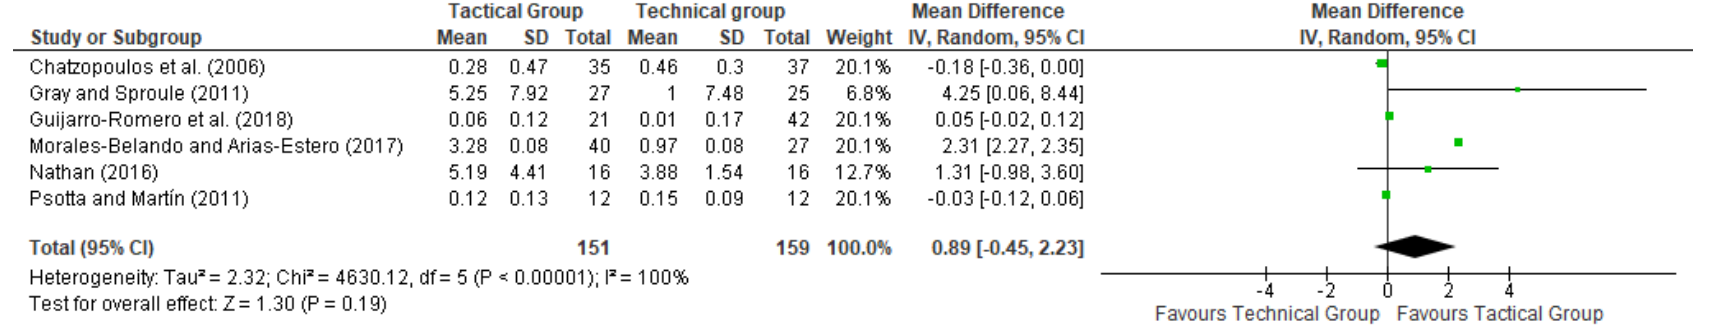
Figure 3. Meta-analysis results of the effects of TEG and TAG on skill execution.